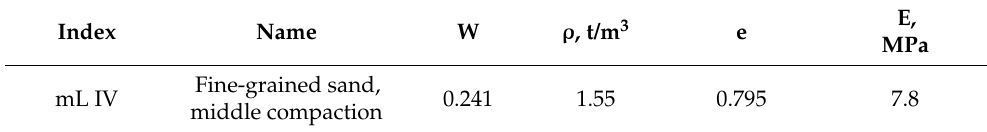
Table 2. Summary of the reference soil’s physical-mechanical